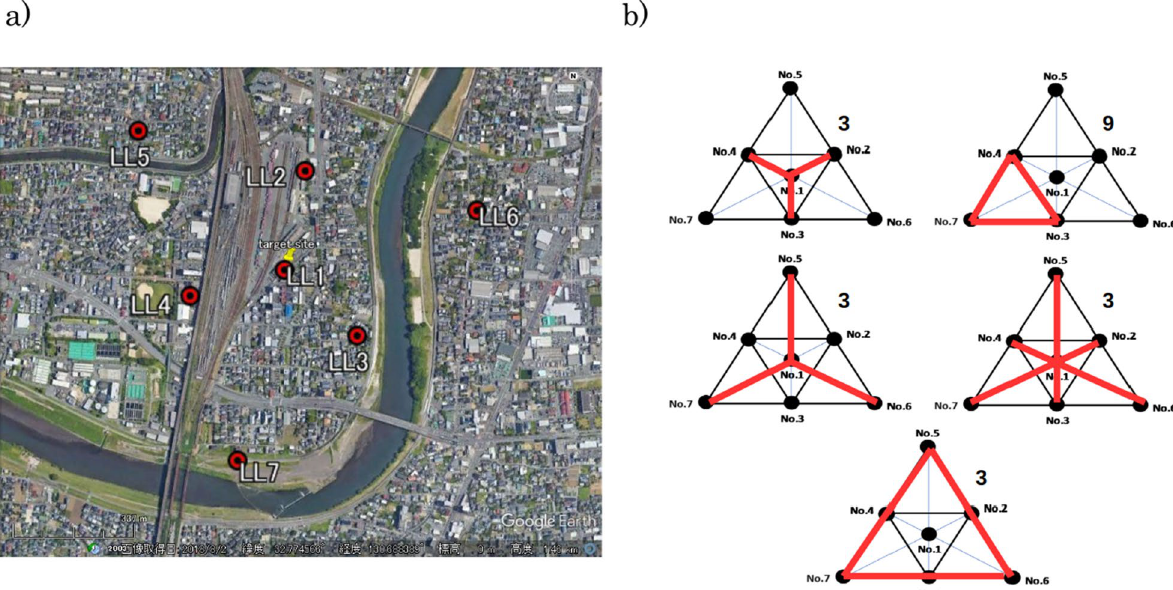
Fig. 2 Survey geometry. a Stations in the KUM-LL array (red circles). The short side is 481 m, and the long side is 962 m. b Sampling schemes of nested-triangle arrays with the different groups of interstation distances (red colors) that are binned and stacked in this ambient noise study. On the top-right of each triangular array, the number of different interstation distance pairs is shown (i.e., 3, 9, 3, 3, and 3 for the longest